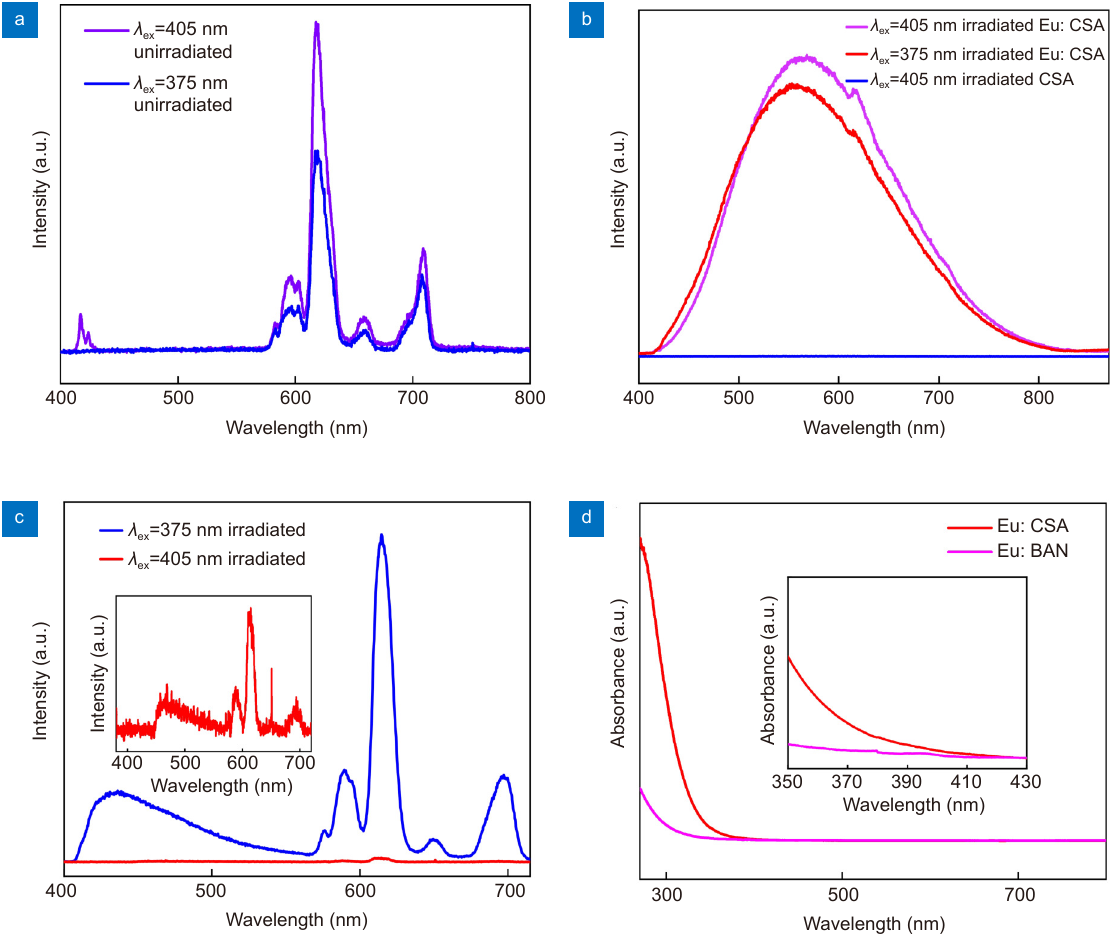
Fig. 1 | ( a ) PL spectra of initial Eu: CSA glass. ( b ) PL spectra of Eu: CSA and CSA glasses after irradiation. ( c ) PL spectra of Eu: BAN glass after ultrafast laser irradiation. The inset is the enlarged PL spectrum excited by 405 nm laser. ( d ) Absorption spectra of Eu: CSA and Eu: BAN glasses. Inset is an enlargement of absorbance from 350 to 430